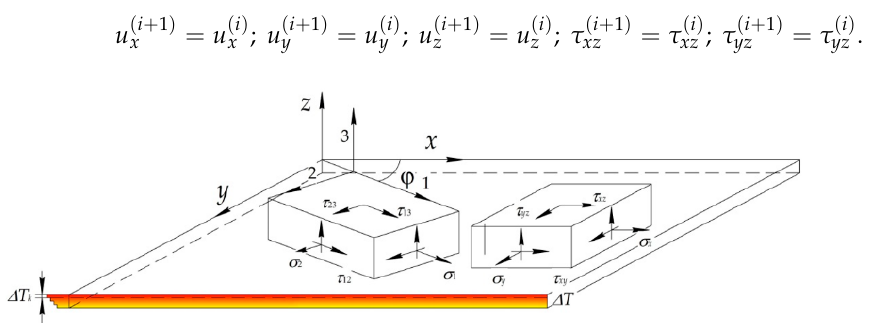
Figure 1. Element of unidirectional layer of PCM in axes 1, 2, 3 related to the direction of reinforcement, and axes x , y , z.